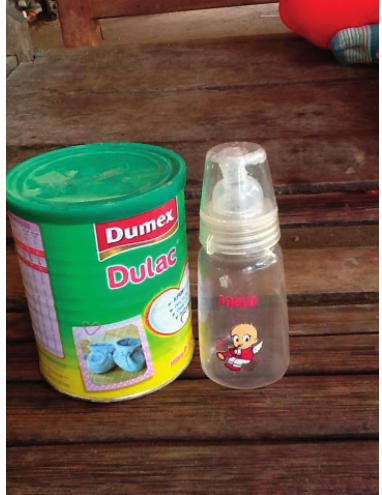
Figure 5. Feeding